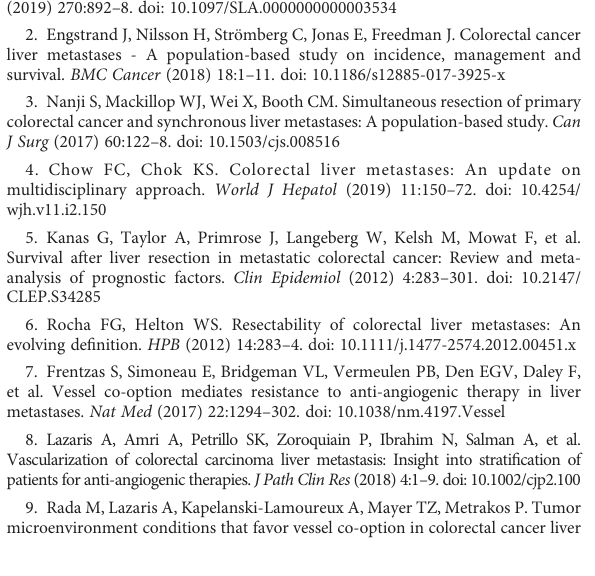
SUPPLEMENTARY FIGURE 1 Original uncropped Western blots of Figure 2. SUPPLEMENTARY TABLE 1 The positivity of the IHC images. SUPPLEMENTARY TABLE 2 The intensity ratio of Western blot